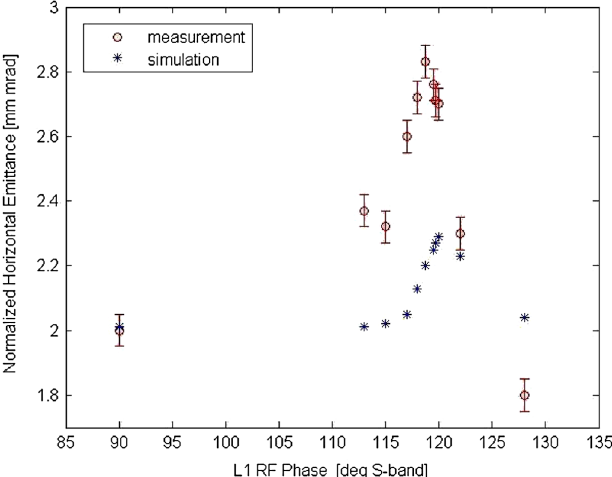
FIG. 6. Comparison of the normalized horizontal emittance measured and simulated as a function of the L1 rf phase. BC1 is set to 85 mrad bending angle. The maximum beam energy occurs at phase 90 (cid:3) while bunch length compression happens for (cid:1) > 90 (cid:3) . The ELEGANT simulations include both CSR and LSC.